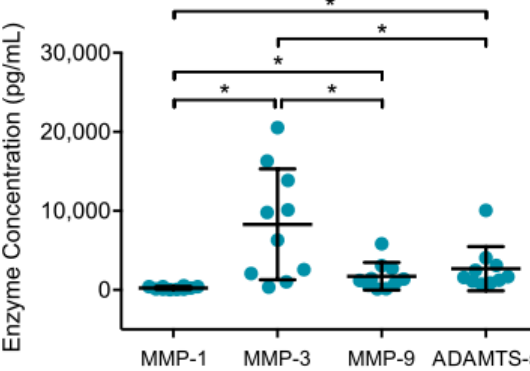
Figure 1. MMP and ADAMTS production in supernatant of synovial cell cultures are displayed. After enzymatic digestion of synovial membrane from patients with advanced knee OA, native synovial cells were cultured for 12 h at 37 °C and 5% CO 2 . Enzyme linked immunosorbent assays were then used to analyze enzyme production in culture supernatants. Mean and standard deviation of enzyme concentrations of MMP-1/-3/-9 and ADAMTS-5 are plotted ( n = 12). Significant differences are indicated by asterisks: * p < 0.05. In addition, production of MMP-13, ADAMTS-5 and ADAMTS-7 were analyzed, but concentrations were below detection level.